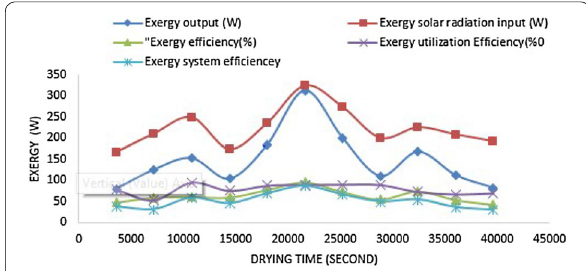
Fig. 14 Variation of efficiency as a function of drying time and exergy in the drying chamber (1st day)